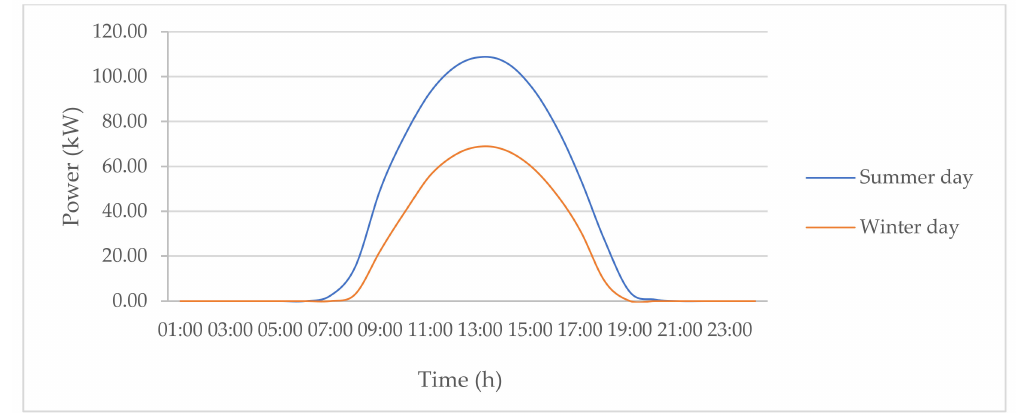
Figure 2. Output power curve of a 140.0 kWp photovoltaic (PV) plant for a typical summer and winter